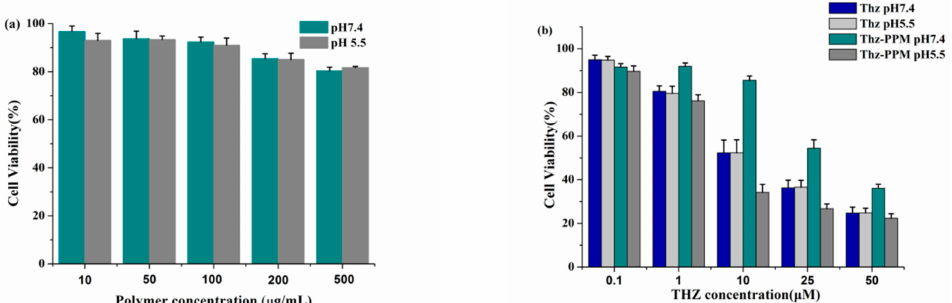
Figure 5. ( a ) Relative cell viabilities of MS cells incubated with blank micelles, ( b ) free Thz and Thz / PPM at pH 7.4 and 5.5 for 48 h ( n =